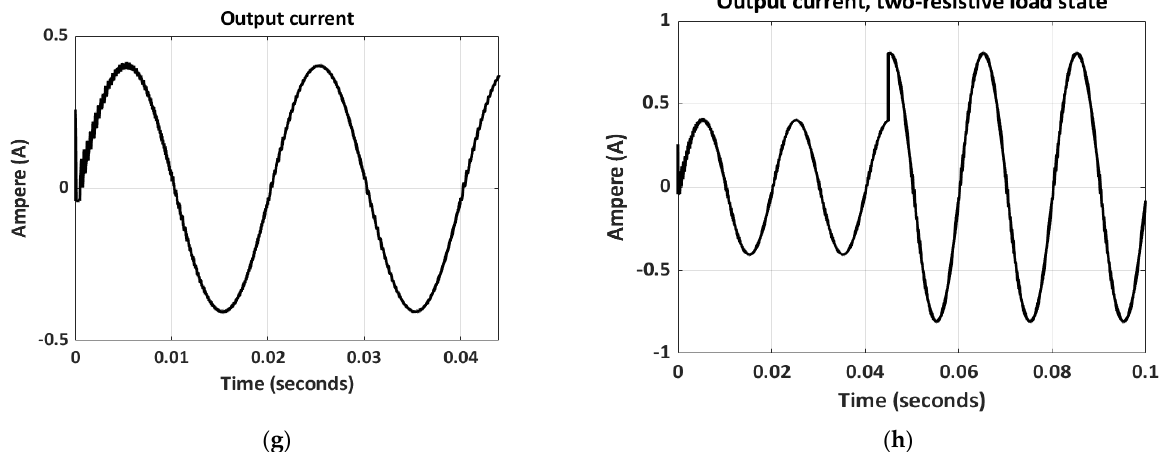
Figure 21. Voltage waveform across the transistors: ( a ) 𝑄 1 − 𝑄 2 ; ( b ) 𝑄 3 − 𝑄 4 ; ( c ) output voltage; ( d ) output current in one-load (RL); ( e ) output voltage in two-load (RL) states; ( f ) output current in two-load (RL) states, ( g ) output current in one-load (R); ( h ) output current in two-load (R) states.